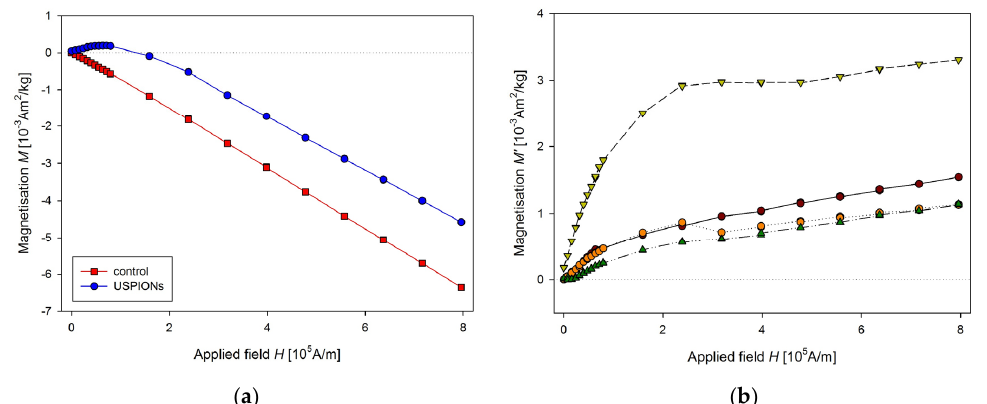
Figure 14. Magnetic properties of the aorta of control and USPION-treated rats. ( a ) The partial M ( H ) dependences at 300 K, ( b ) corresponding M ’ data for individual rats of the USPION treated group after subtraction of the control group average. Data (a) are presented as the averaged curve from the control group ( n = 4) and USPION-treated group ( n = 4). The mass of dry samples was in the range of 1.8–2.5 mg.